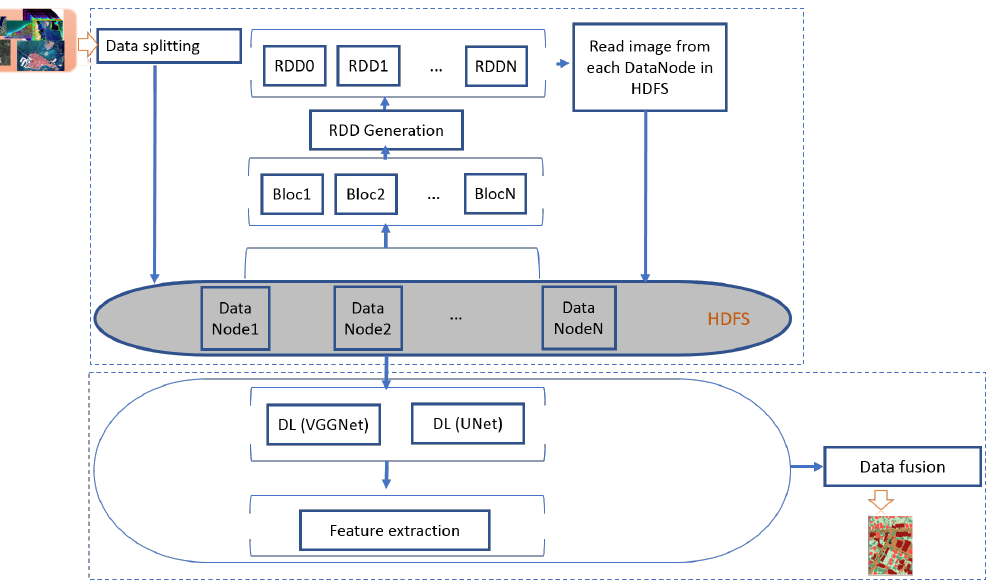
Figure 2. Flowchart of the proposed